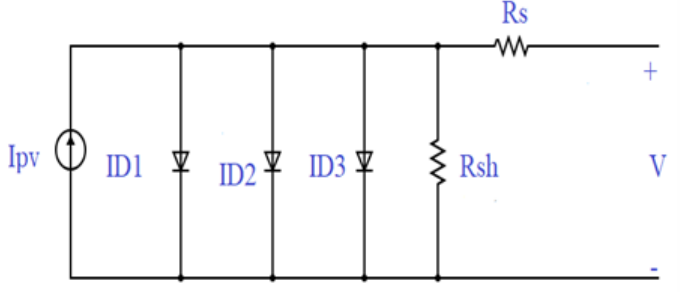
Figure 3. Equivalent circuit of the